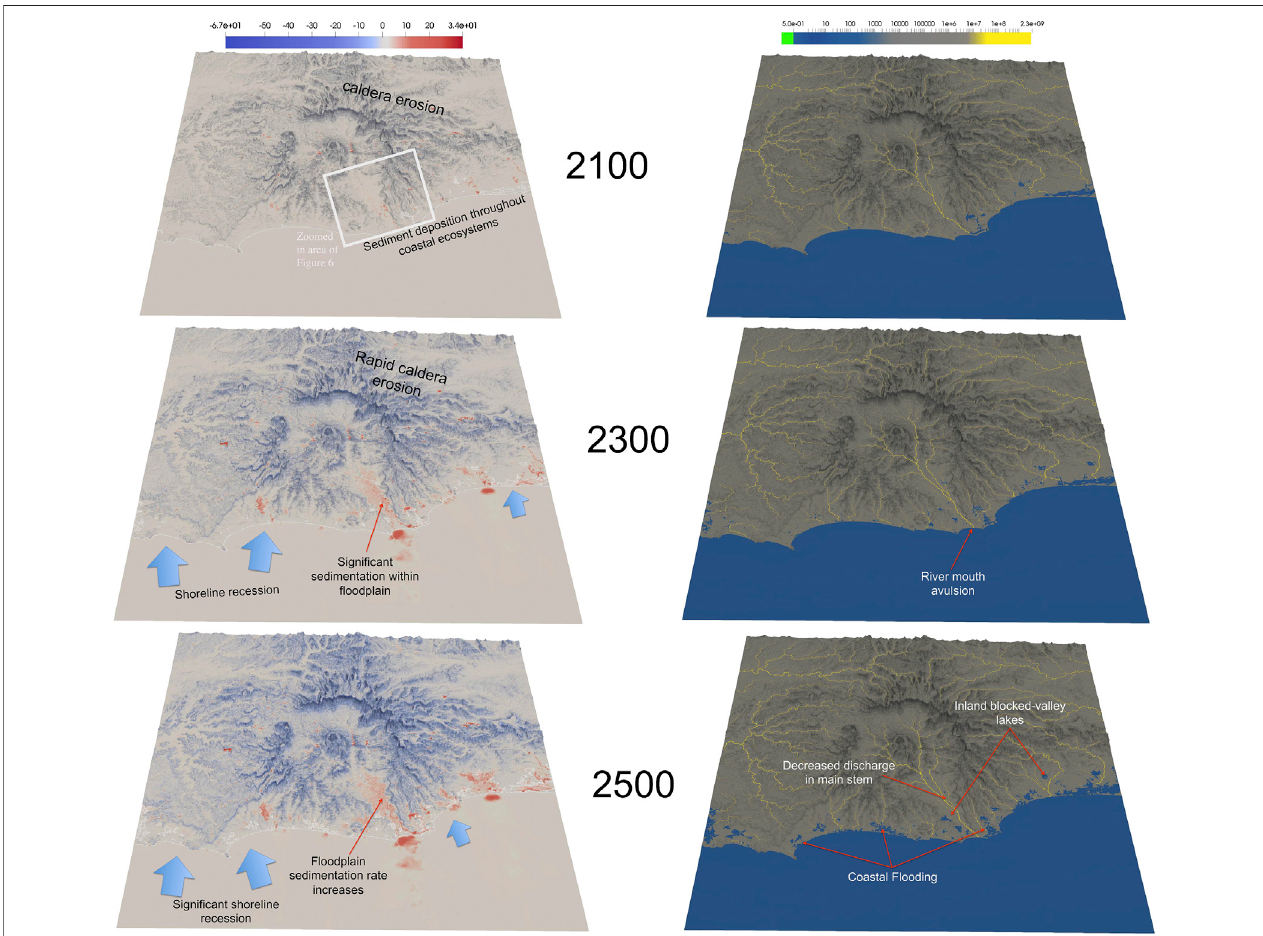
FIGURE 5 | Visualizations of Representative Concentration Pathways 8.5 erosion and deposition, with red regions indicating areas of deposition and blue regions indicating areas of erosion (m 2 /a) (left) . Visualizations of discharge with brighter yellow colors indicating greater discharge rates (m 2 /a) (right) demonstrating dynamic differences between 2100, 2300, and